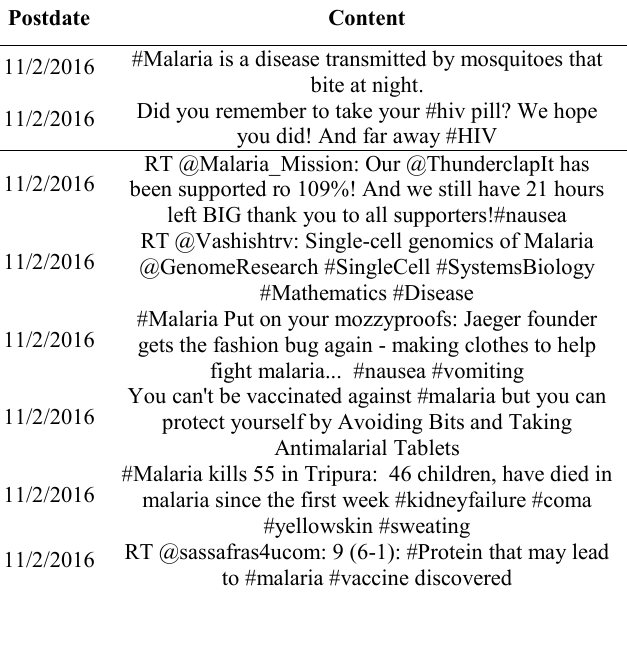
Table 3. Random Sample Tweets